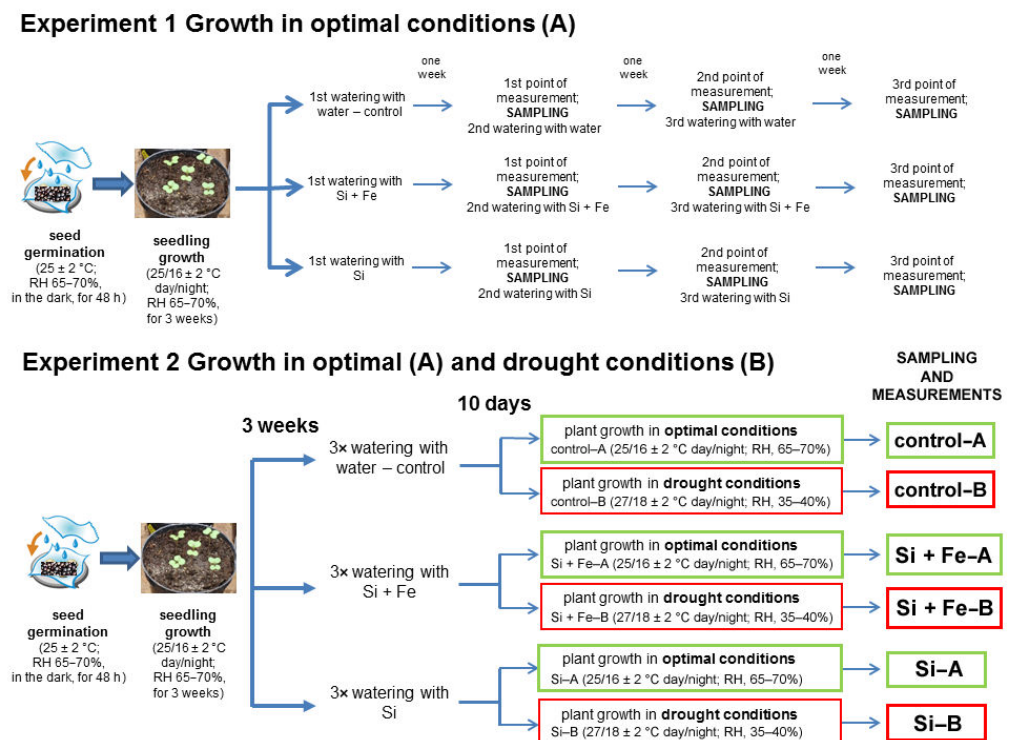
Figure 5. The scheme of two experiments conducted on oilseed rape plants. In both Experiments 1 and 2, plants grew for 44 days under optimal conditions and were watered three times with water (control), silicon and iron (Si + Fe), or silicon (Si). In Experiment 2, the plants then grew for 10 days under optimal conditions ( A ) or drought ( B